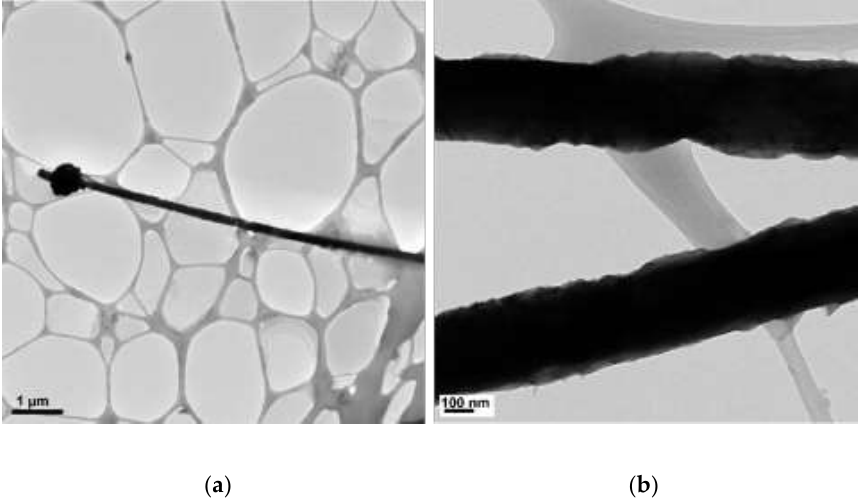
Figure 4. TEM images of copper products at 60 ° C: ( a ) scale bar 1 µm; ( b ) scale bar 100 nm.